Question: According to the figure, is the described quantity increasing or decreasing?
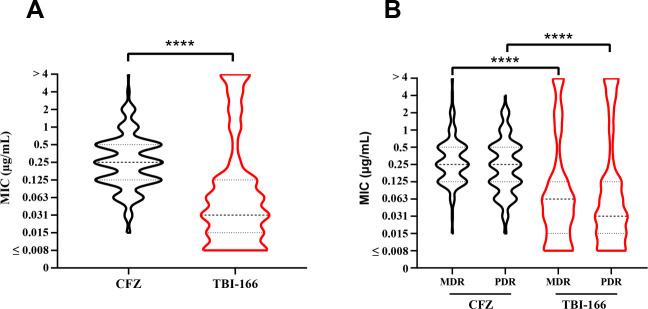
Answer: increasing